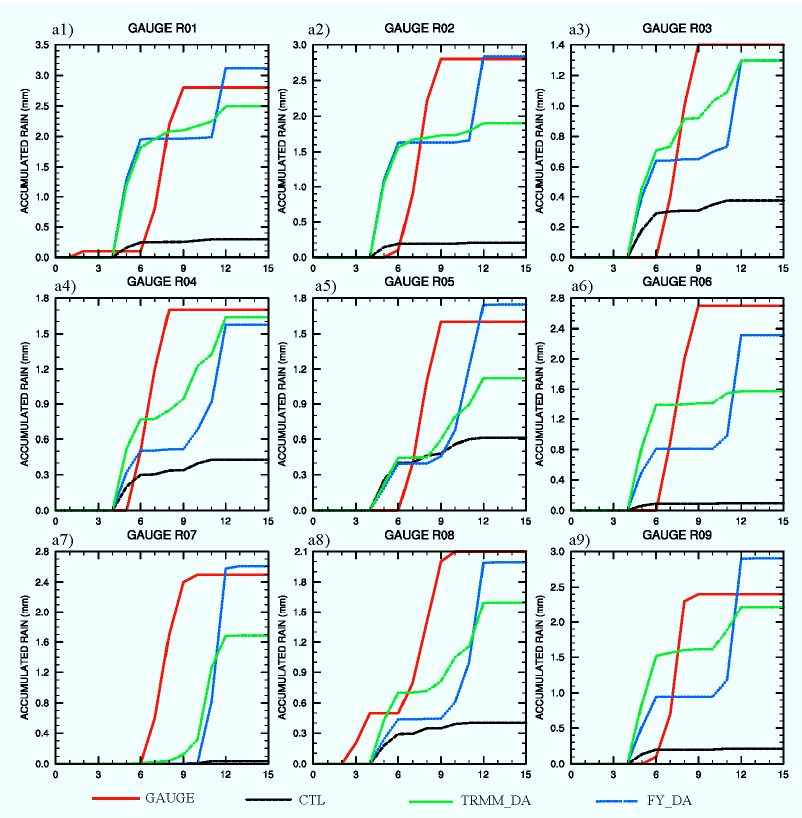
Figure 9. Comparisons of accumulated rainfall curves for the control simulation, TRMM assimilation, FY assimilation, and gauge observations (from 00:00 UTC to 15:00 UTC on 21 June 2008): (a1–a9) from Gauge R01 to Gauge R09.